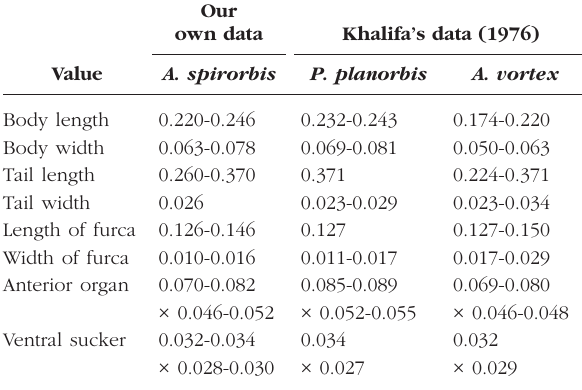
Table IV. – Main morphometric differences in the cercariae D. loossi (sizes in mm).